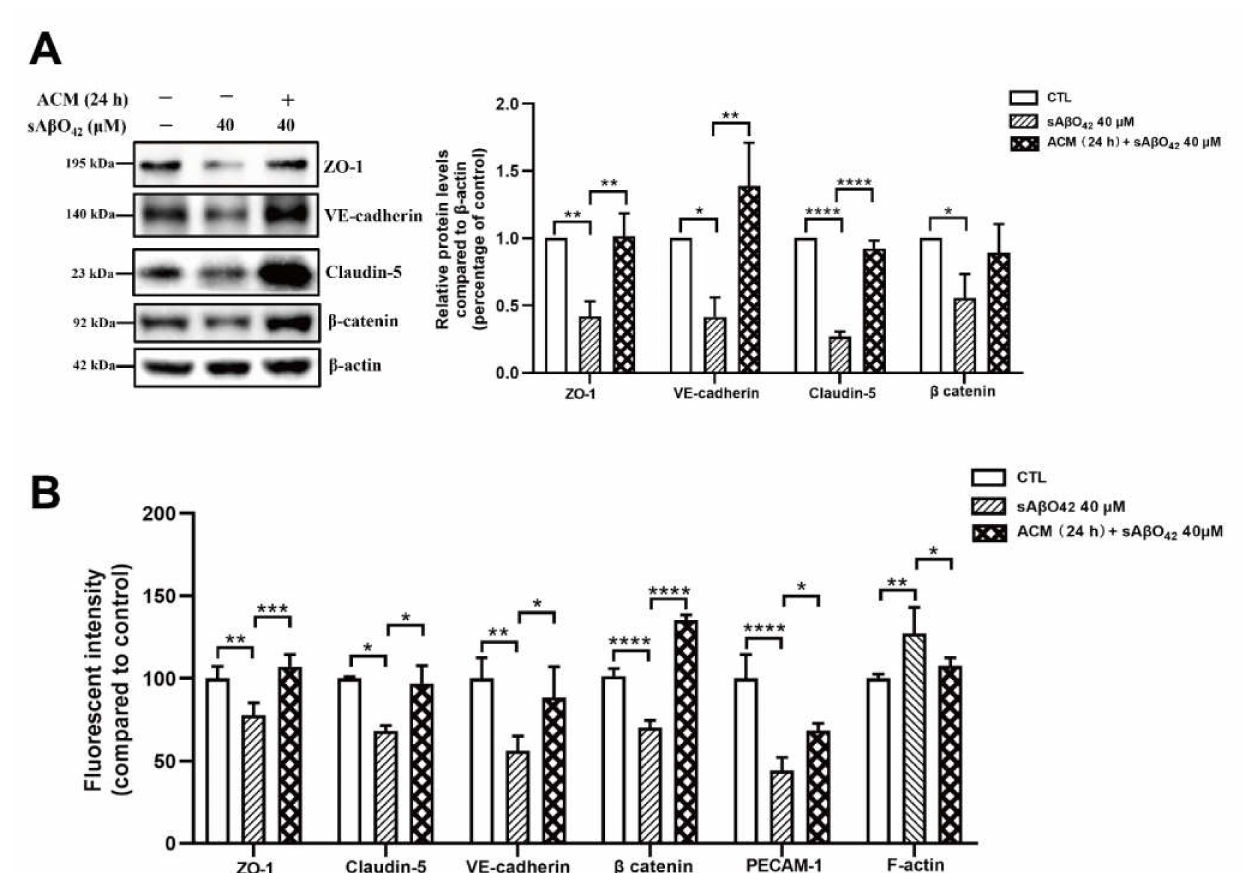
Figure 7. Resting ACM protected normal expression levels of junctional proteins in bEnd.3 cells against sA β O42 stimulation. ( A ) The protein expression level of junctional proteins ZO-1, VE- cadherin, claudin-5, and β -catenin in bEnd.3 cells. ( B ) Fluorescent intensity of junctional proteins ZO-1, claudin-5, VE-cadherin, β -catenin, PECAM-1, and cytoskeleton protein F-actin in bEnd.3 cells. Data are shown as means ± SD of at least three independent experiments and were analyzed by one-way ANOVA followed by a post hoc Dunnett’s test and a post hoc Tukey’s test. * p ≤